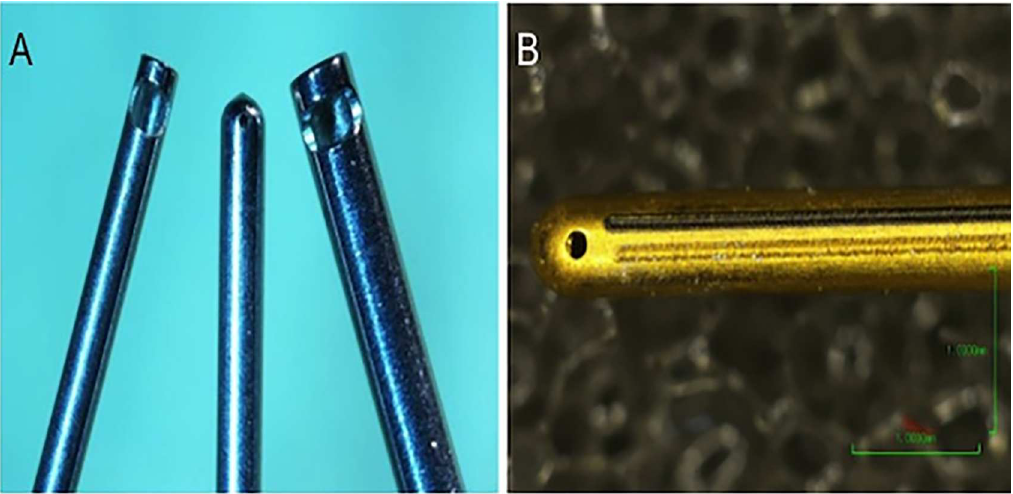
Fig 1. Comparison of the HV vs. conventional guillotine vitreous cutter. (A) 23-gaugehypersonic vitrector needle (center) comparedwith 25-gauge (right) and 23-gauge(left) of guillotineneedle. (B) High-magnificationimage of the tip and port of the hypersonic